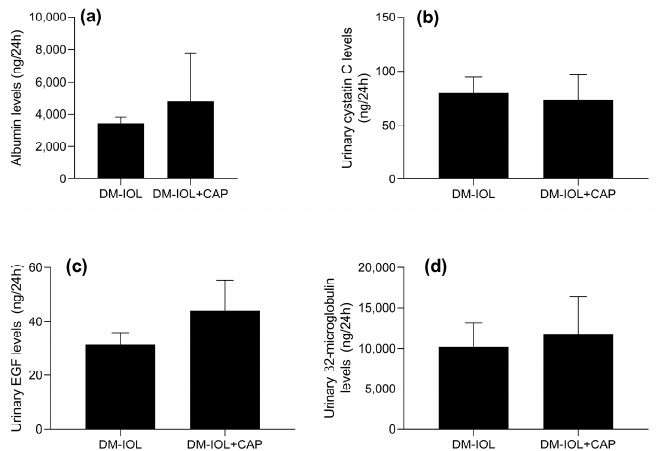
Figure 4. Capsaicin (CAP) effects on kidney disease biomarkers in rats with diabetes (DM) and iron overload (IOL), without or with capsaicin treatment (DM-IOL or DM-IOL + CAP, respectively). Graphs show changes in the levels of ( a ) albumin; ( b ) cystatin C; ( c ) EGF; and ( d ) beta-2-microglobulin in 24 h urine samples from experimental IOL groups. Urine samples were diluted 1:500. Data are expressed as the mean ± standard error. p > 0.05, Student’s t test with post-hoc Bonferroni test.